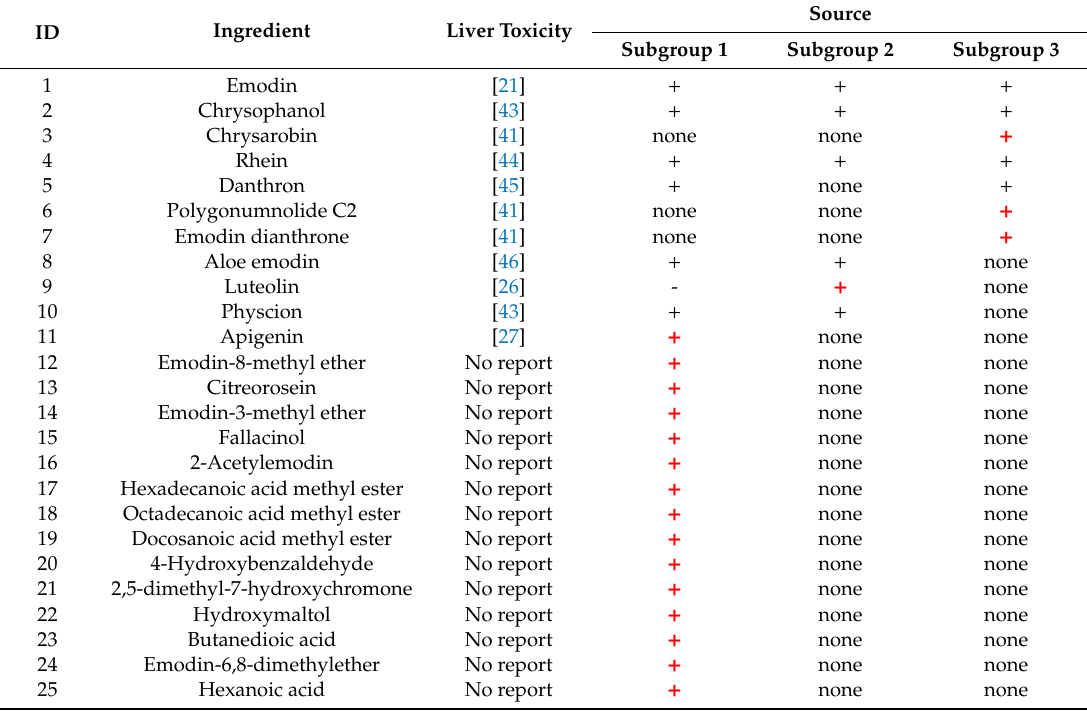
Table 5. Hepatotoxic ingredients in PmT identified by the computational toxicology